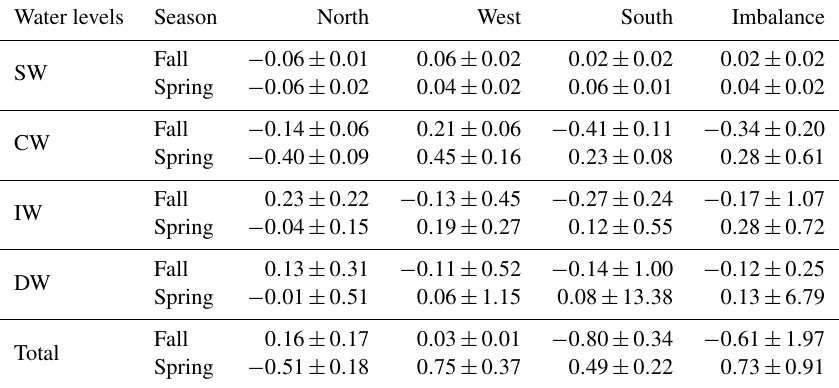
Table 5. SiO 2 transports and their errors (kmols − 1 ) for CW, IW and DW for the north, west and south transects. Positive–negative values indicate outward–inward transports. The last row is the integrated transport in the entire water column in each transect, and the last column represents the net transport for this variable inside the